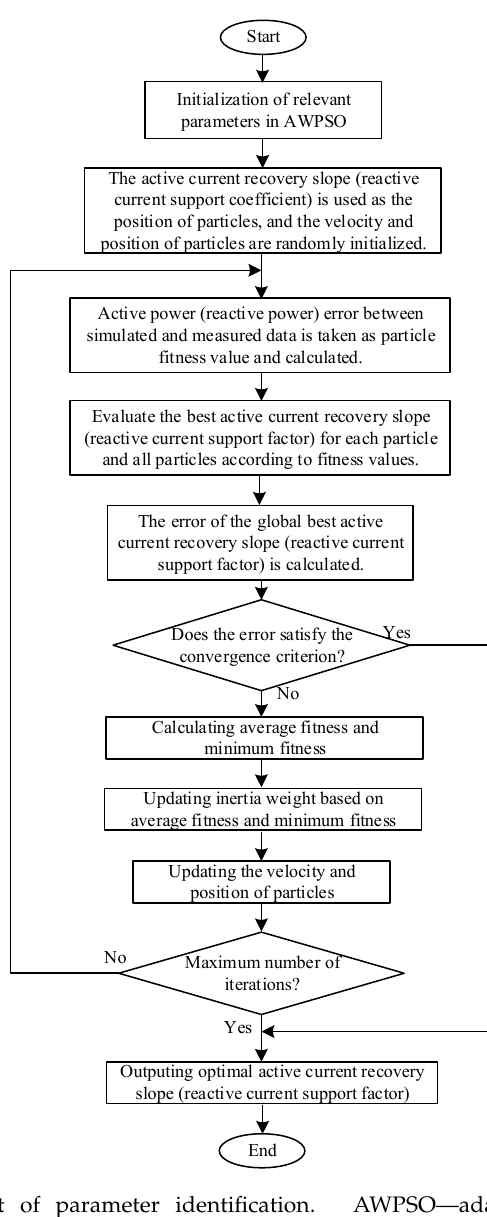
Figure 8. Flow chart of parameter identification. AWPSO—adaptive weighted particle swarm optimization.